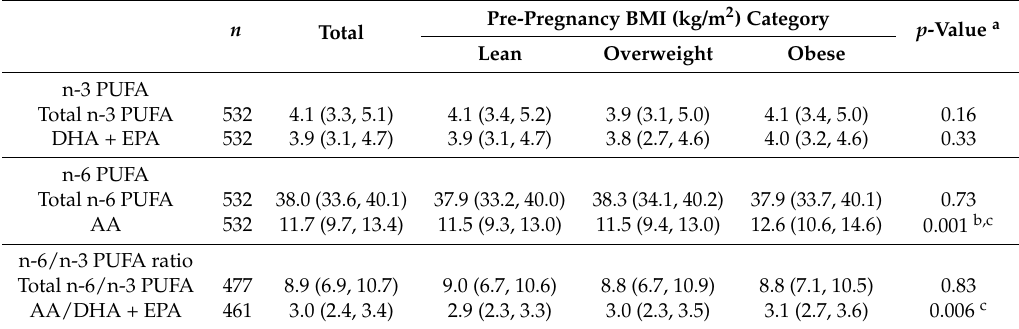
Table 2. Baseline plasma PUFA concentrations, overall and by maternal BMI category.